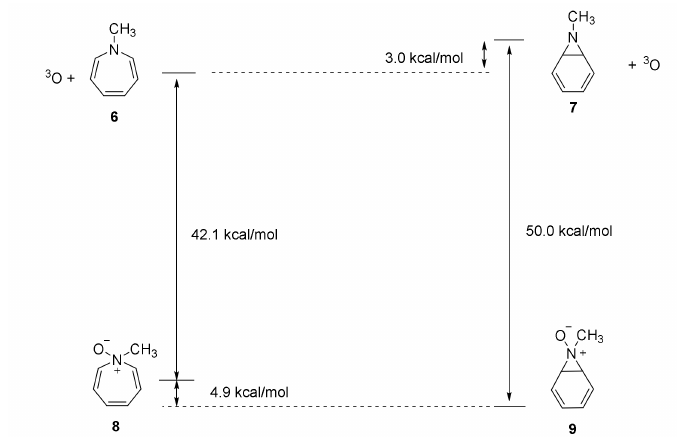
Figure 1. Enthalpy comparisons (kcal / mol; 1.000 kcal = 4.184 kJ) between the lowest enthalpy stereoisomers of N -methylazepine N -oxide ( 8 ) and its 7-azanorcaradiene N -oxide valence isomer ( 9 ) and the corresponding amines ( 6 and 7 ) plus triplet oxygen atom ( 3 O). The values employed in this figure are from M06 / 6-311 + G(d,p) calculations. Table 4. Calculated enthalpies of reaction ( ∆ H r , kcal / mol) for isodesmic Equations (3) and (4).